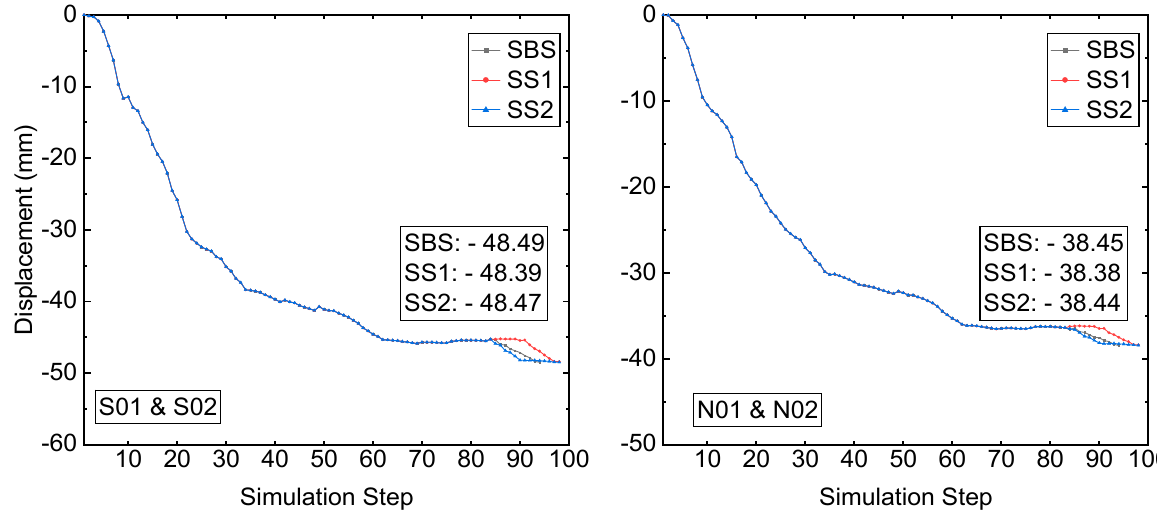
Figure 7. A comparison of the displacement at monitored sites S01-02 and N01-02. During the mining and backfilling of the three mining blocks, the mining-induced displacement at the three monitoring zones reaches a value of 46.7 mm (CRF-S) and 39.55 mm (CRF-N), respectively. From the mining-induced displacement view, the three different schemes of sill pillar recovery have very close results at the two monitoring zones. Also, the displacement induced by the process of sill pillar recovery sees a slight increase at Table 3. Sill pillar recovery induced displacement at monitoring zones. all three monitoring zones. Table 3 presents the displacement induced by the process of sill pillar recovery at the monitoring